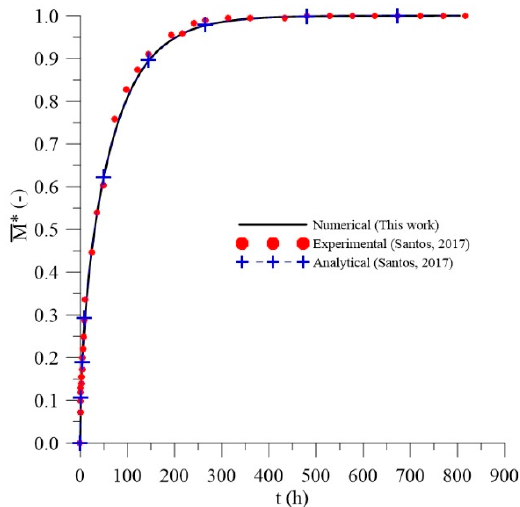
Figure 10. Comparison between the average dimensionless moisture contents predicted by the numerical and analytical solutions and the experimental data as a function of the process time.